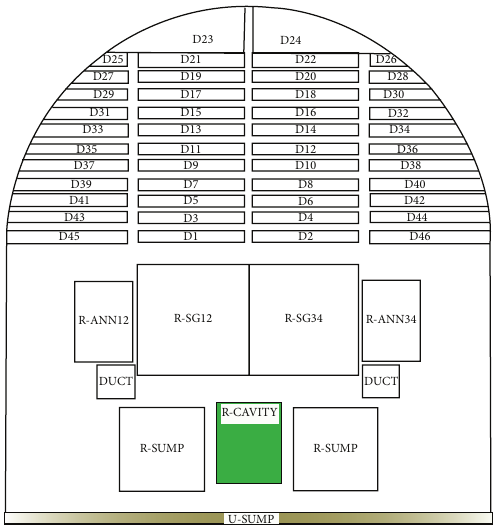
Figure 2: COCOSYS model.